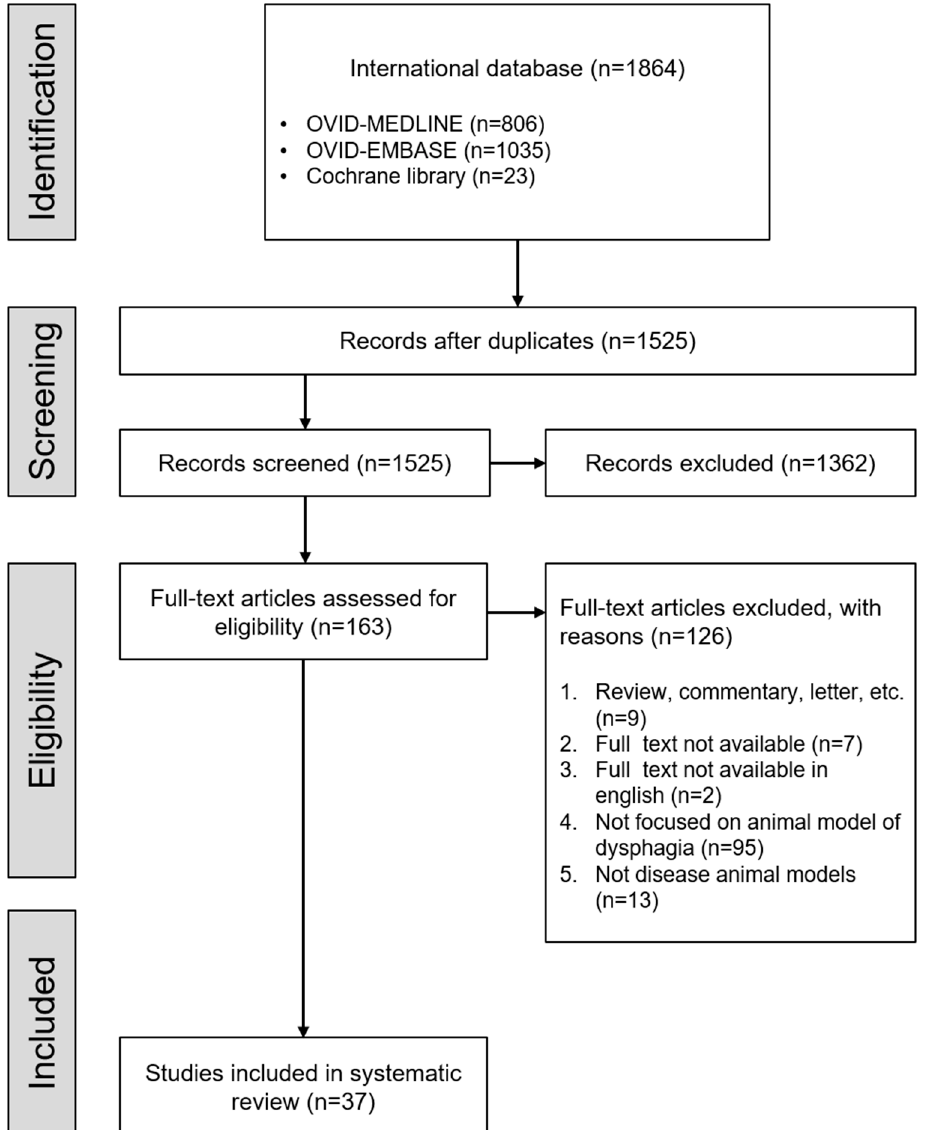
Figure 1. Flowchart of the study selection process.